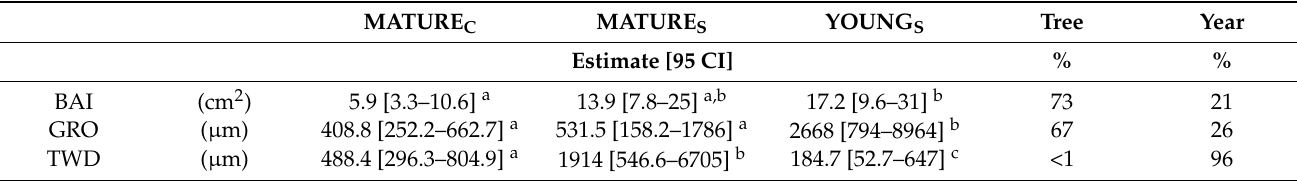
Table 2. Estimates and confidence intervals (CI) derived from linear mixed effect models (LME) for total year basal area increment (BAI), stem radius increment (GRO) and tree water deficit indicator (TWD) of individual tree groups and the variance partitioning of the random effects (years and trees). Letters indicate significantly different tree groups. See Table S1 for details.